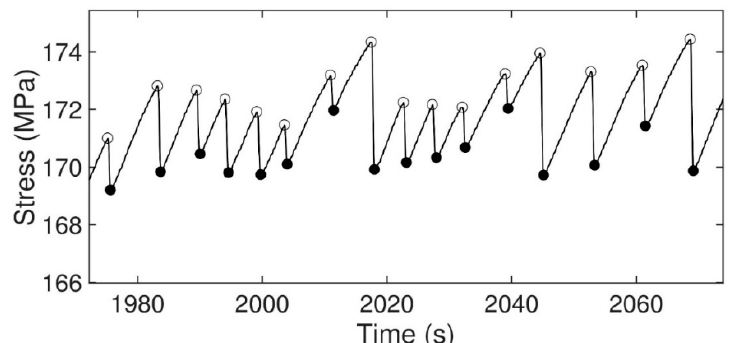
Figure 10. Determination of maximum and minimum peaks.